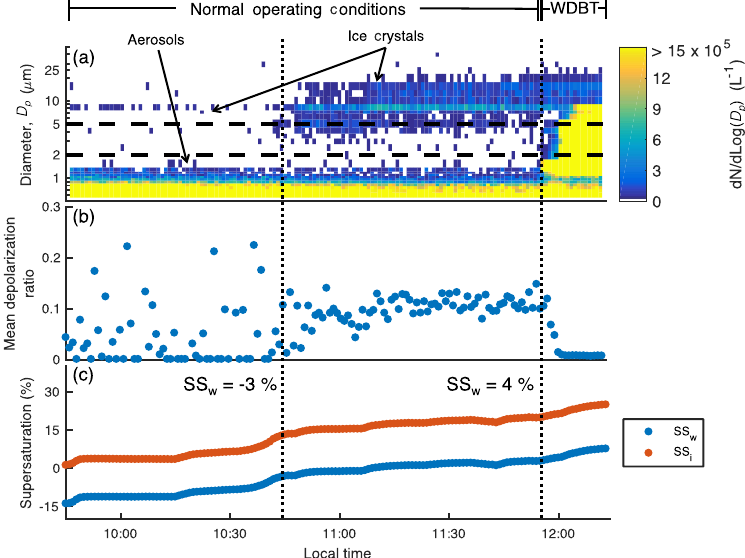
Figure 4. (a) The normalized size distribution, (b) mean depolarization ratio of particles in CFDC with diameter > 2µm, and (c) supersatu- ration conditions with respect to ice (SS i ) and water (SS w ) for a Snomax ® scan on 27 March at − 15 ◦ C ± 1.5 ◦ C (case no. 27 in Table 1). The dashed lines in the figure denote the onset of abundant ice nucleation (10:45) and the onset of WDBT